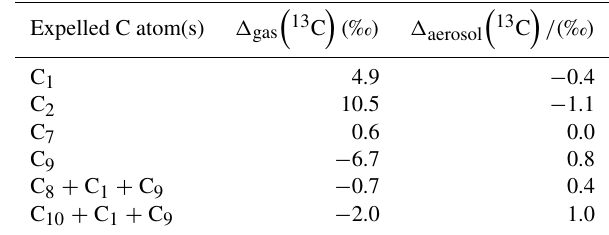
(cid:16) (cid:17) 13 C values, assuming that fragmentation Table 5. Calculated (cid:49) yields certain C atoms to be expelled to the gas phase and oth- ers to partition to the aerosol phase (details in Sect. 4.1). Calcula- tions based on position-specific measurement results of the Sigma- Aldrich sample in Table 1. See Fig. 7 for numbering of C atoms.